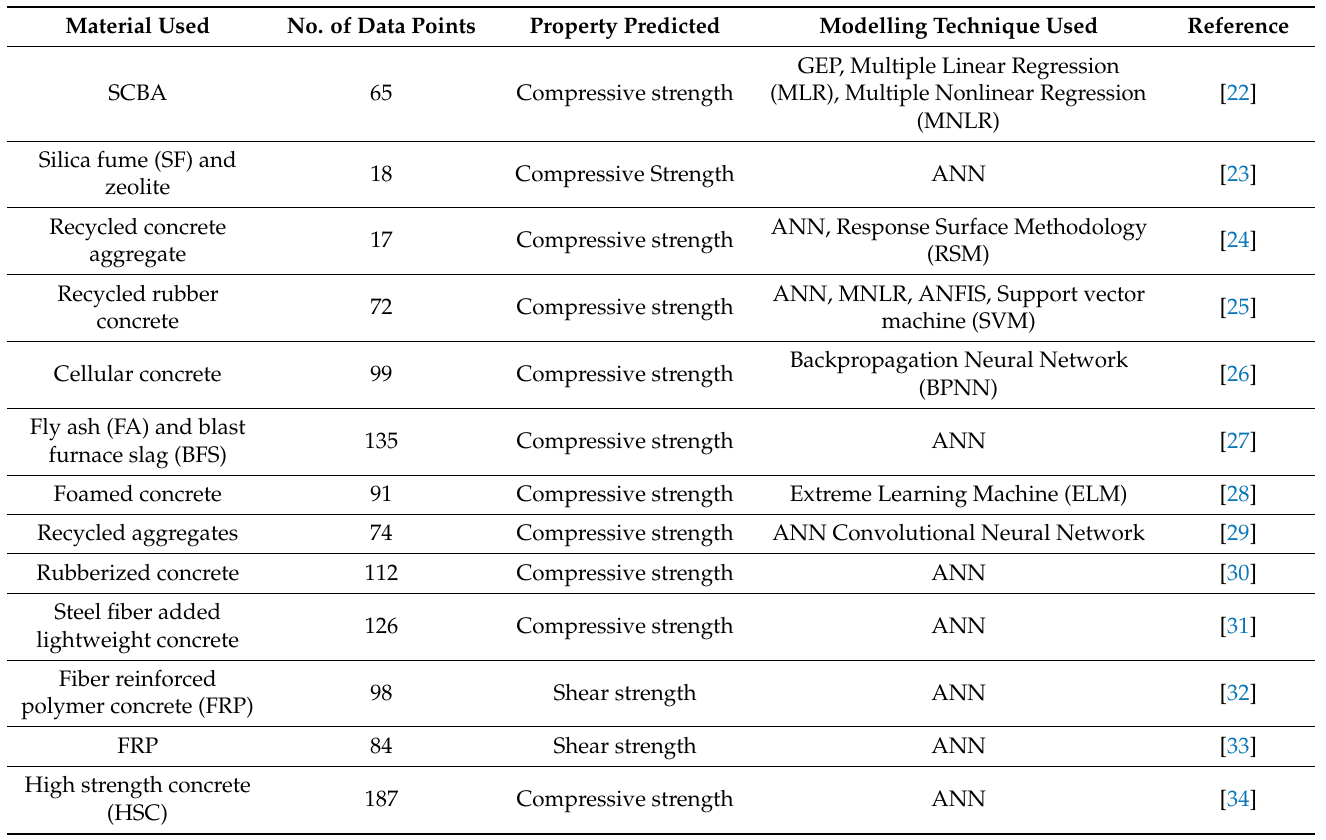
Table 2. Some recent studies using AI.